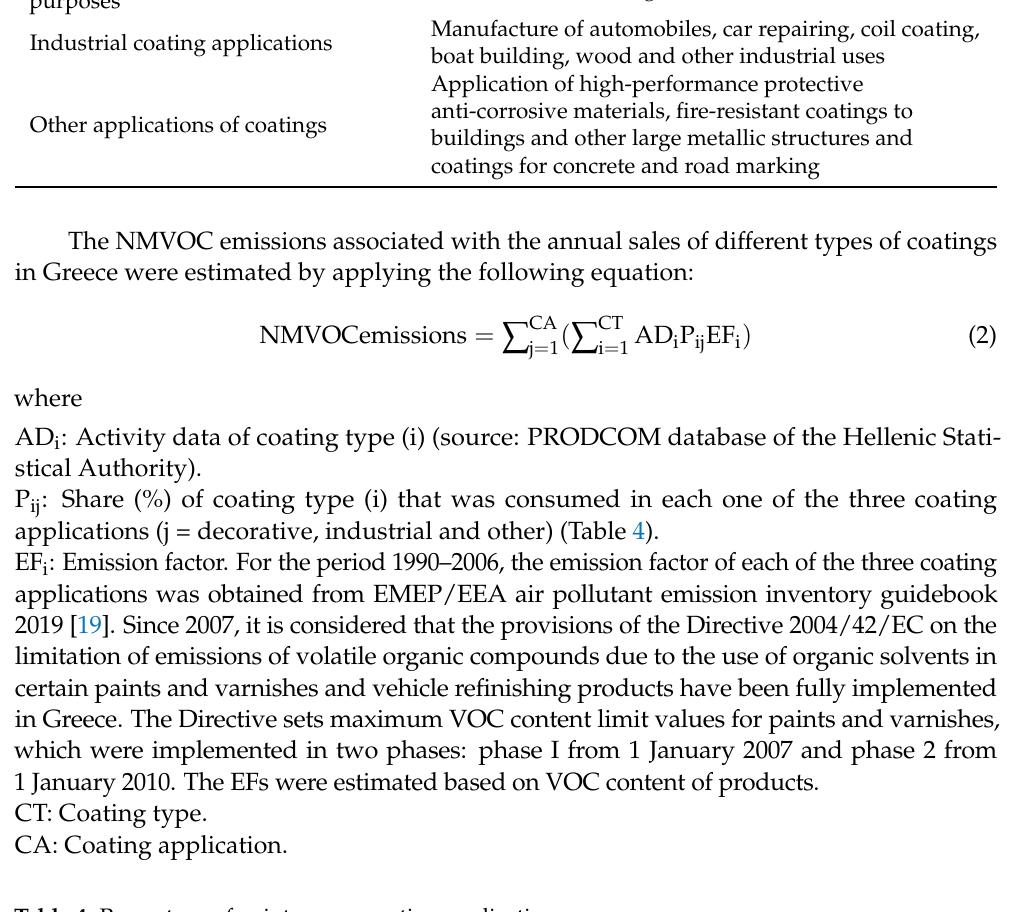
Table 4. Percentage of paint use on coating